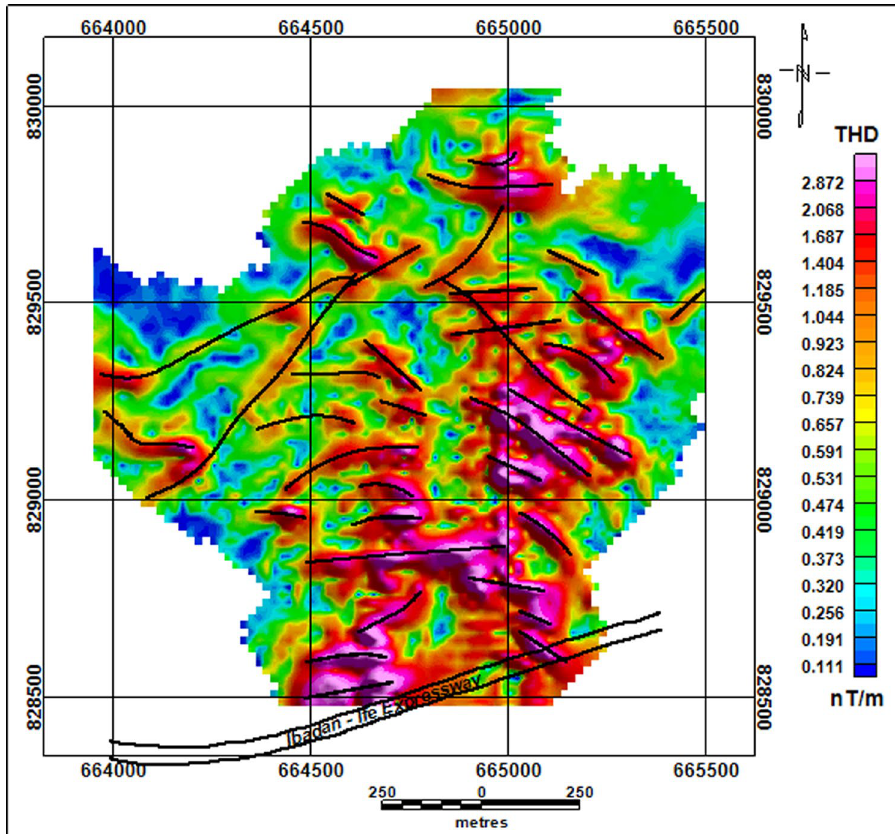
Fig. 6 Total horizontal deriva- tive (THD) map of the study area showing identified linea- ments with black